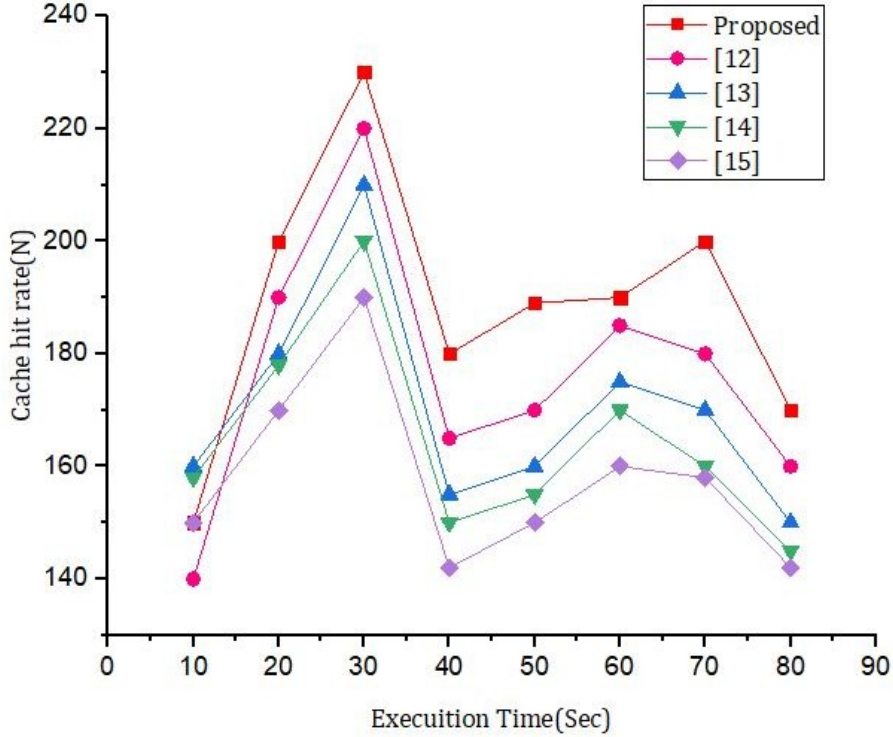
Figure 16. Simulation results based on the execution time and the cache hit rate. Figure 17 represents the simulation results based on the true positive rate and the false positive rate. We classified the IoT data into different classes based on TP and